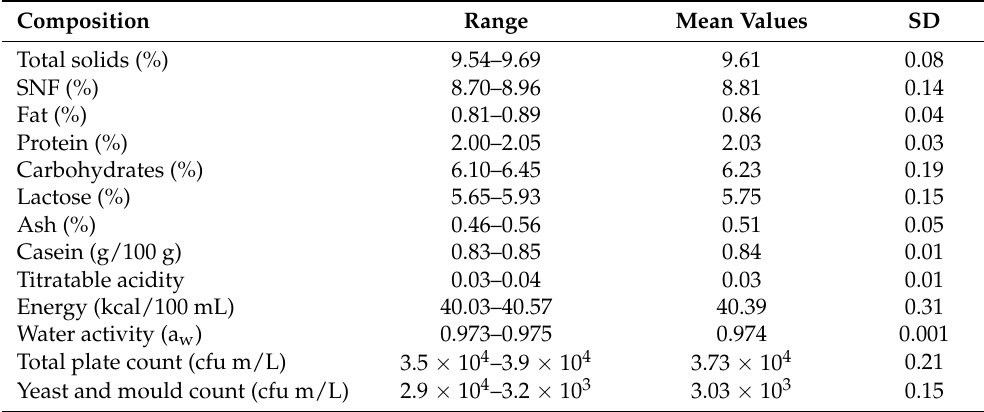
Table 1. Descriptive statistics of physicochemical properties of Halari donkey